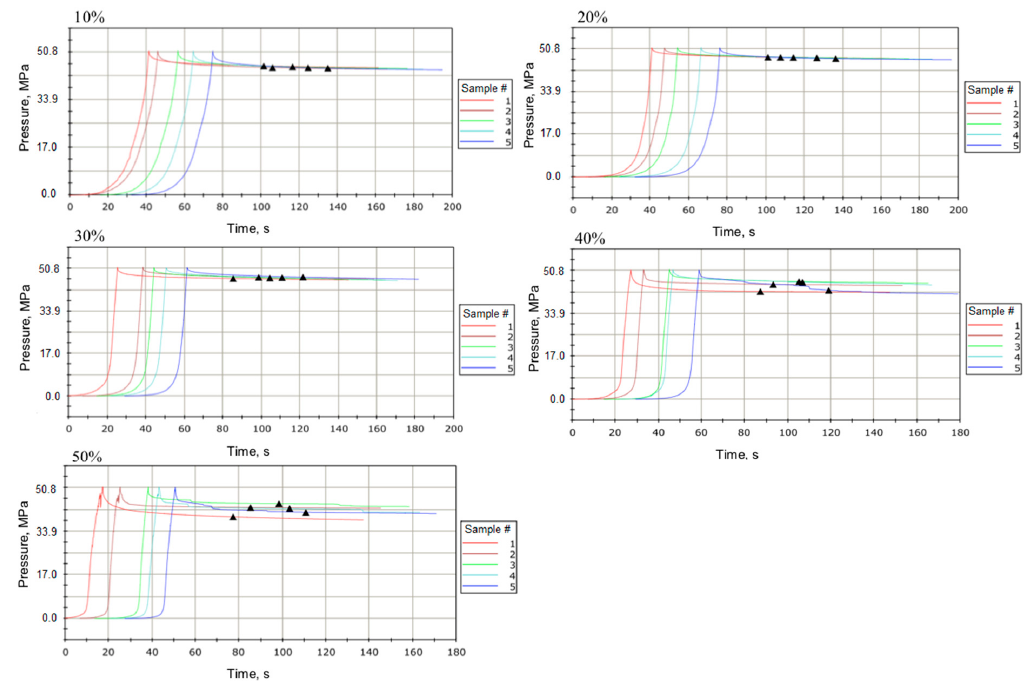
Figure A4. The densification (pelletization) of carbonized refuse-derived fuel (CRDF) with a pressure of 50.8 MPa, and with a water glass content ranging from 10% to 50%.